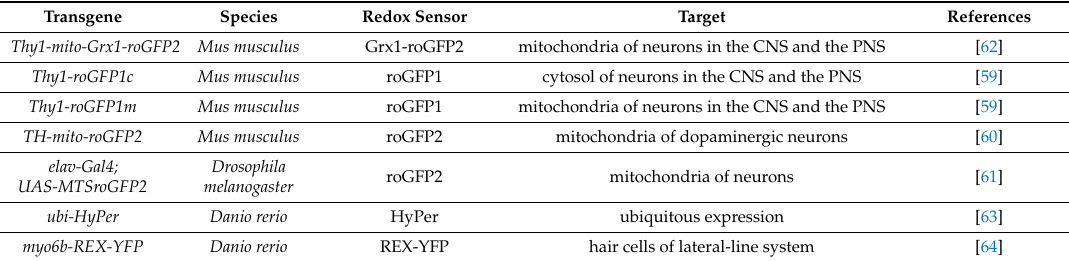
Table 3. Transgenic organisms with redox sensors targeted to nervous